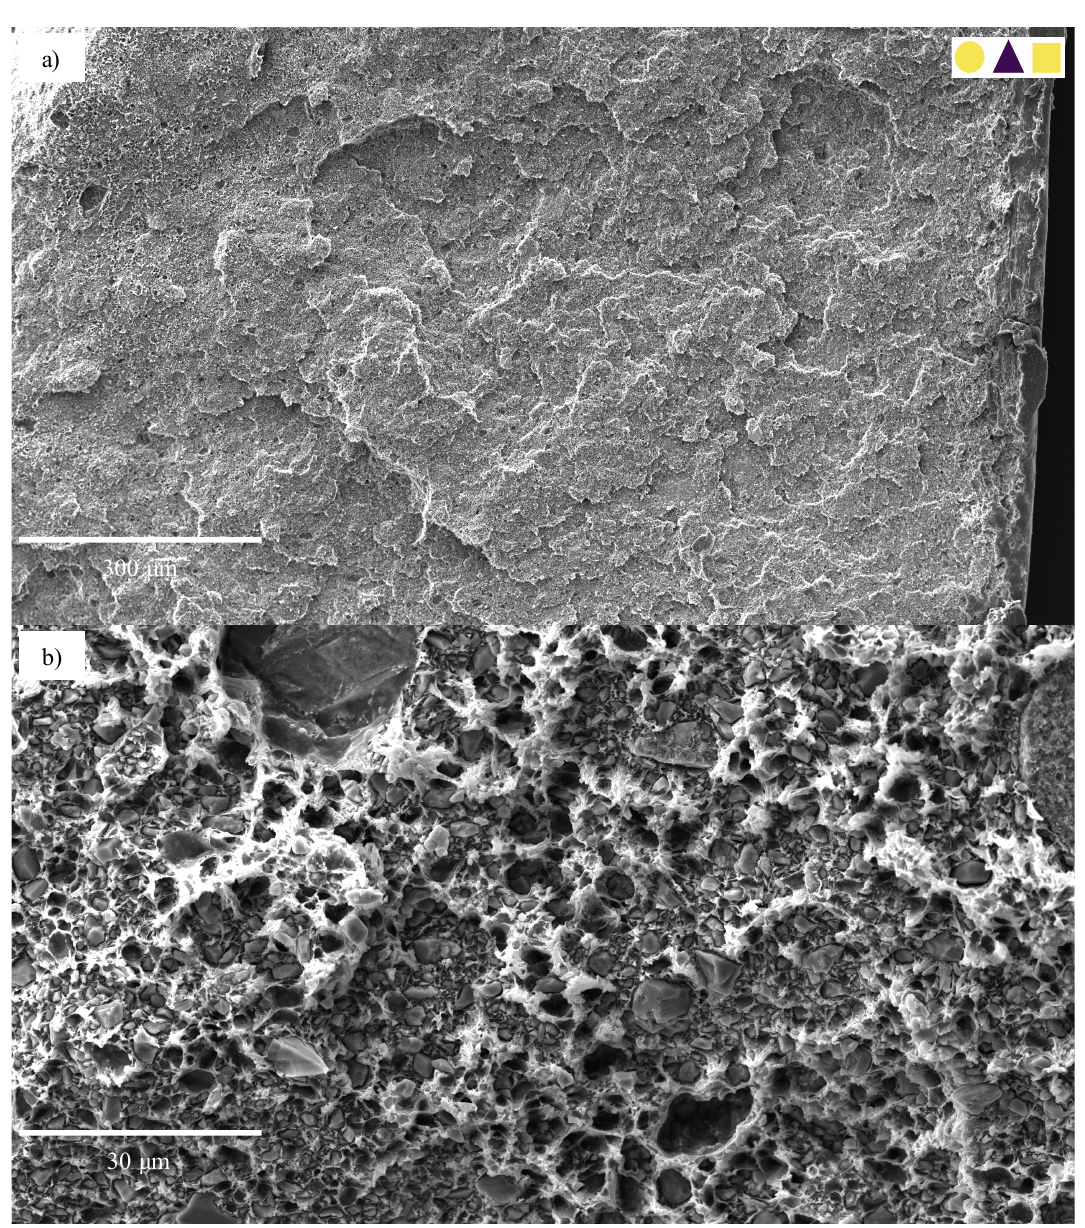
Figure 26. SEM micrographs of the failure regions of a 0-CB/60-CC/0-SP REF specimen: ( a ) general near-perimeter morphology showing shift towards unstable crack propagation; ( b ) detail of fibrillation and particle effects further away from the perimeter, with increased fibrillar extension compared to that in Figure